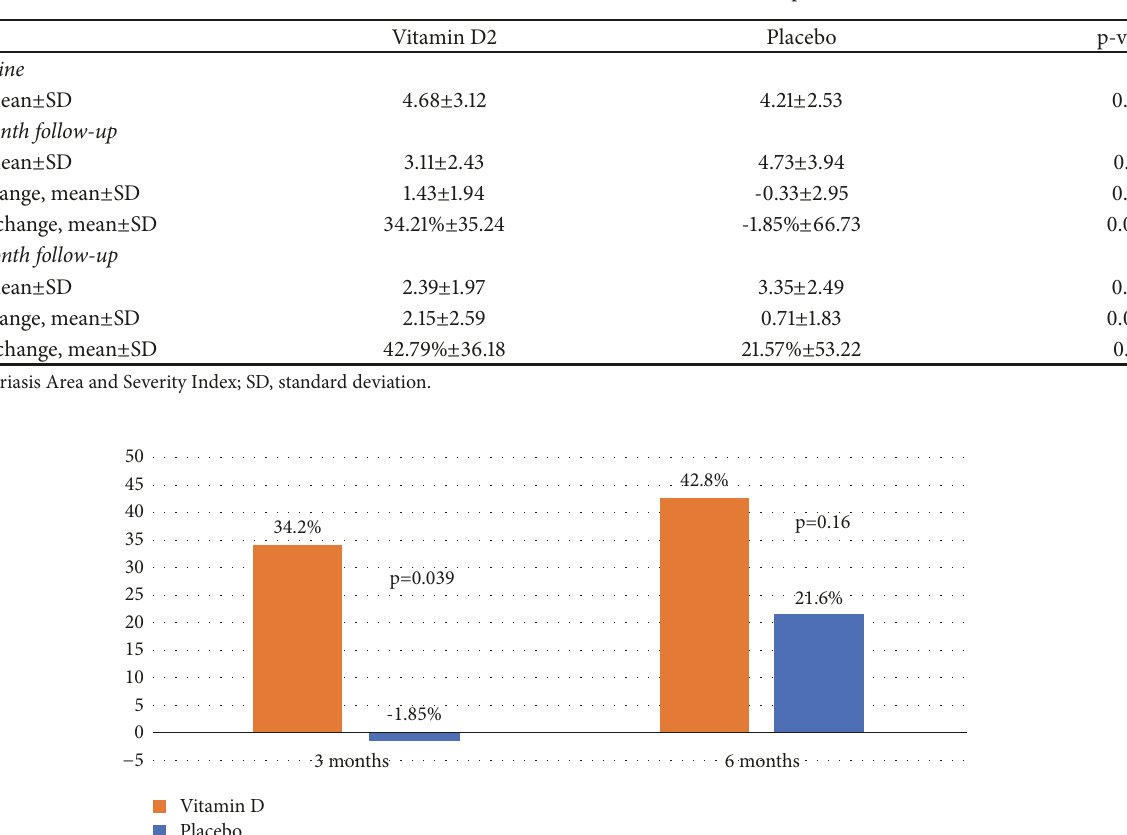
Table 2: Outcomes at the 3-month and 6-month follow-ups.